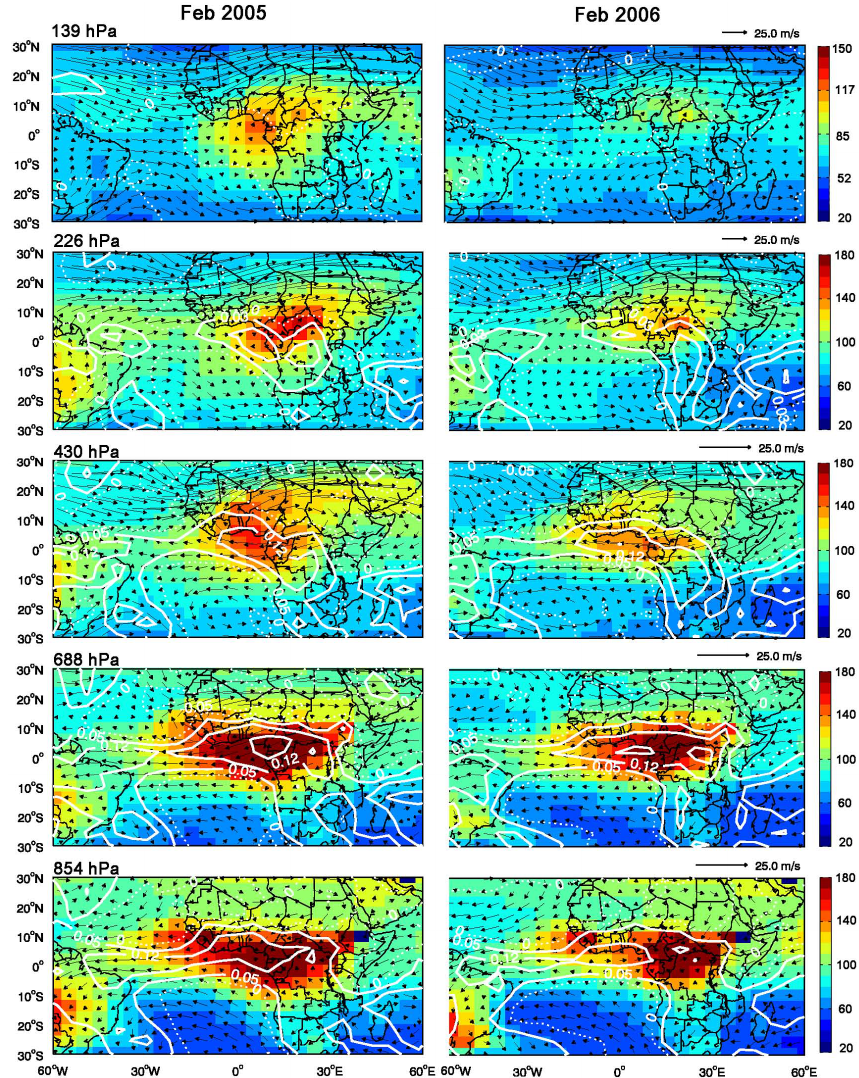
Fig. 23. CO mixing ratio overlaid with horizontal wind vectors in February 2005 and 2006 at 854, 688, 430, 226 and 139hPa in for GEOS-4 simulations. The vertical air mass flux (Pas − 1 ) is shown by contours: ( − 0.05, 0, 0.05, 0.12, 0.2) for 854, 688, and 430hPa, and ( − 0.05, 0, 0.03, 0.06, 0.12) for 226hPa. Positive values are upward fluxes (solid lines), negative values are downward fluxes